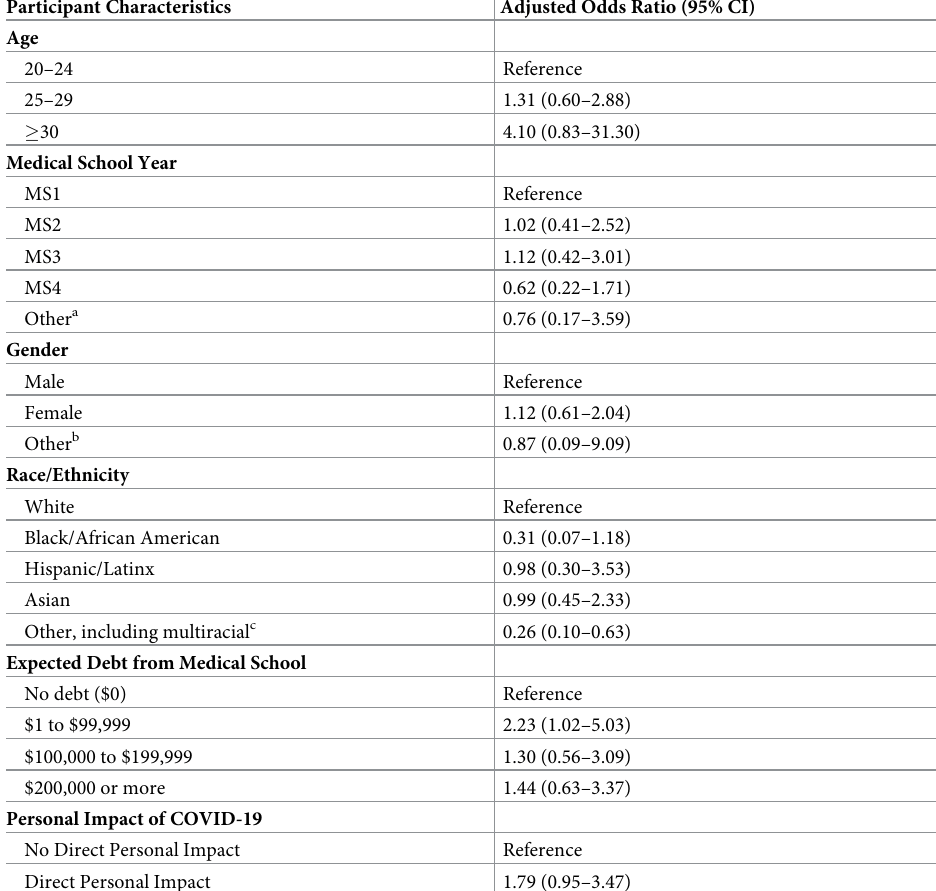
Table 3. Multivariable logistic regression of characteristics associated with COVID-19 impacting specialty choice, in 212 New York City medical students. Participant